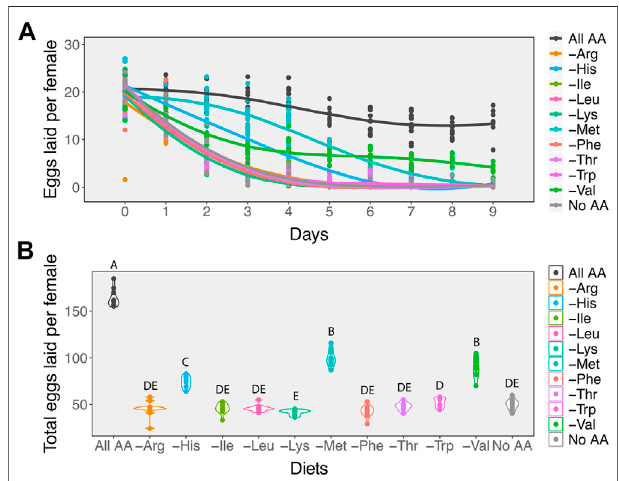
FIGURE 2 | Amino acids differ in their effects on egg laying. (A) While in mostcasesremoving individualessentialaminoacidsresultsinarapiddecline in egg laying at a rate similar to removing all amino acids from the diet, removing valine, histidine, or methionine results in a slower rate of decline. (B) For most diets in which a single amino acid is removed, the total number ofeggs that females produce over a 9-day period issimilartofemales on a diet that contains no amino acids. Females on either histidine, valine, or methionine drop-out diets produce more eggs than those on diets missing any of the other essential amino acids. Diets that have differing letters are signi fi cantly different, as determined from post hoc pairwise comparisons derived from a generalised linear model assuming a Poisson